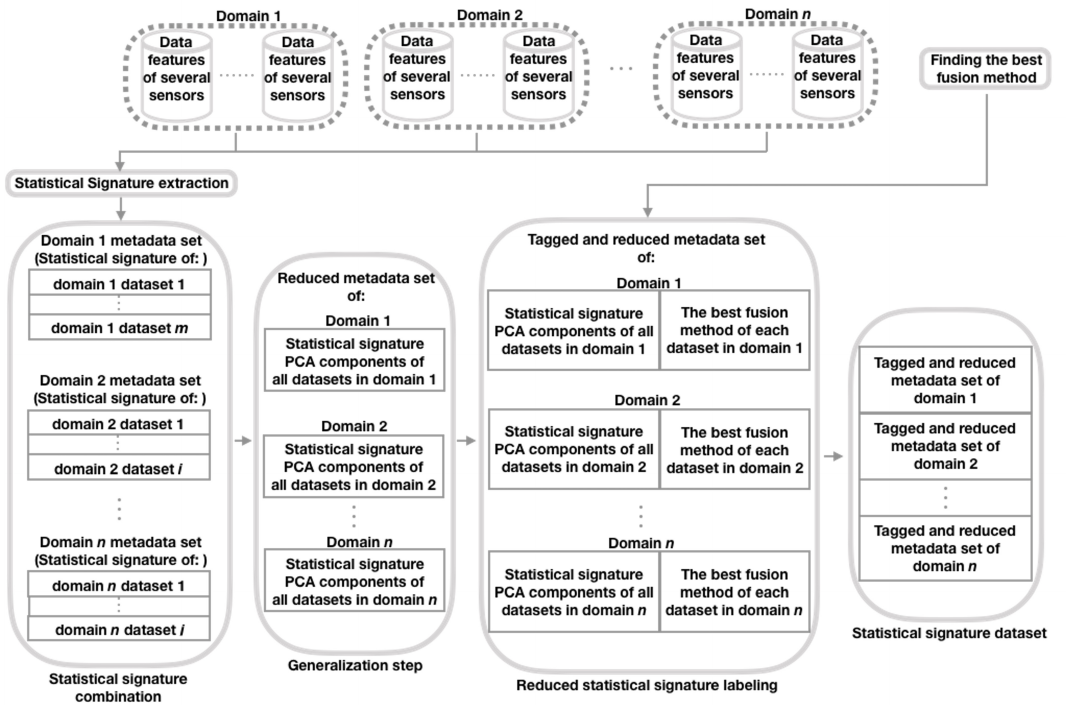
Figure 2. Procedure to create the Statistical signature data set. PCA = Principal Component